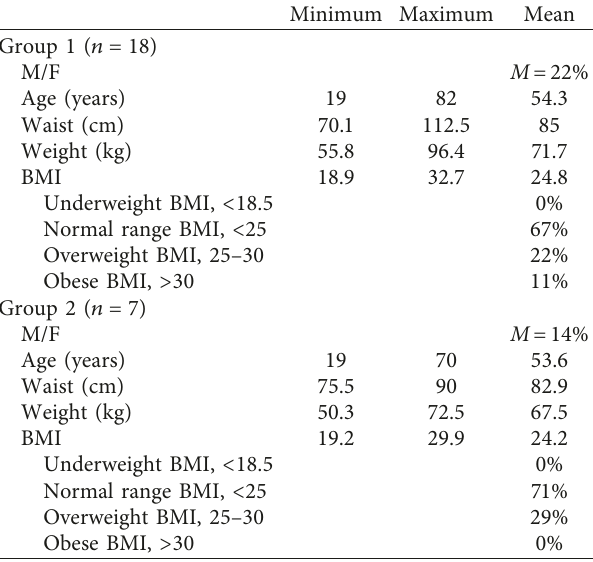
Table 1: Subject group